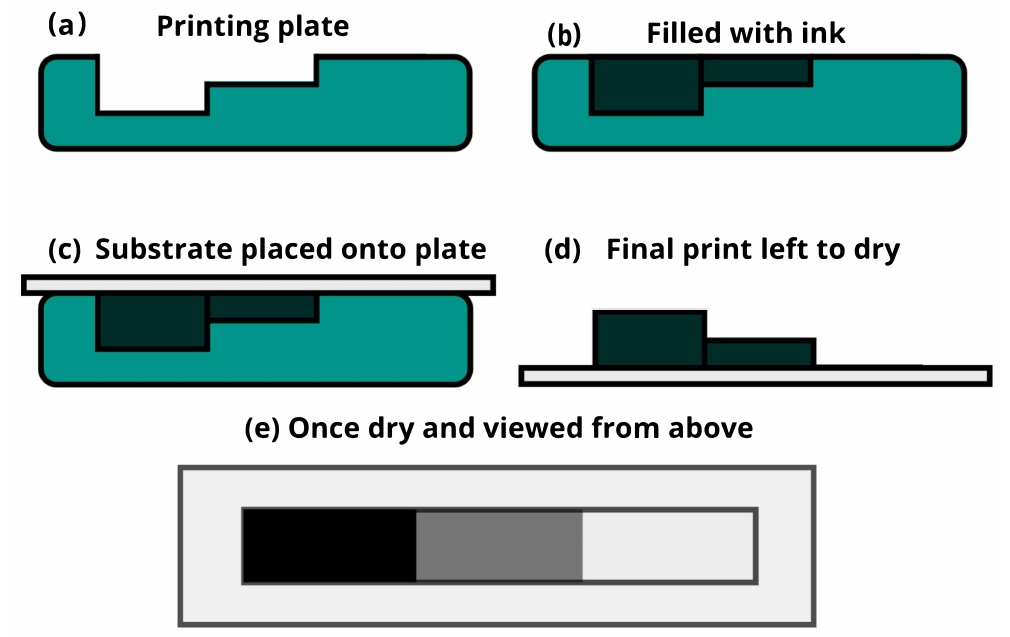
Figure 1. A pictorial version of the general Woodburytype process. ( a ) A relief printing plate is produced, with depths to indicate changes in tone. ( b ) The relief plate is filled with the gelatin ink—recipe described in the text. ( c ) The plate and ink are pressed against the desired substrate and allowed to set. ( d ) Once set, it is pulled from the plate and allowed to dry under ambient conditions. ( e ) A example of how the tone arises from the varying heights of the films of translucent ink mixture is